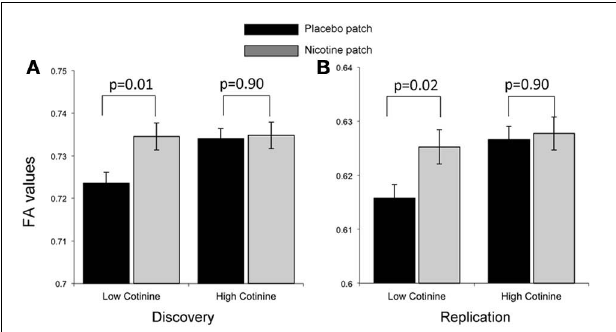
FIGURE 3 | Treatment effect on FA values for the genu of corpus callosum by comparing placebo (black bar) and nicotine (gray bars) showed a significant interaction with average cotinine level in the discovery cohort (A). Subjects in the discovery cohort were separated into two (low and high cotinine) equal groups by sorting the data based on cotinine levels, with the average cotinine levels = 208 ± 77 and 428 ± 94mg/ml, respectively. Nicotine enhanced the FA in the low-cotinine group ( p = 0 . 01) but not in the high-cotinine group. (B) The low and high cotinine groups in the replication cohort had average cotinine levels = 194 ± 49 and 364 ± 73mg/ml, respectively. Note that the discovery and replication cohorts were collected under different DTI protocols, leading to a systematic difference in the average FA values.